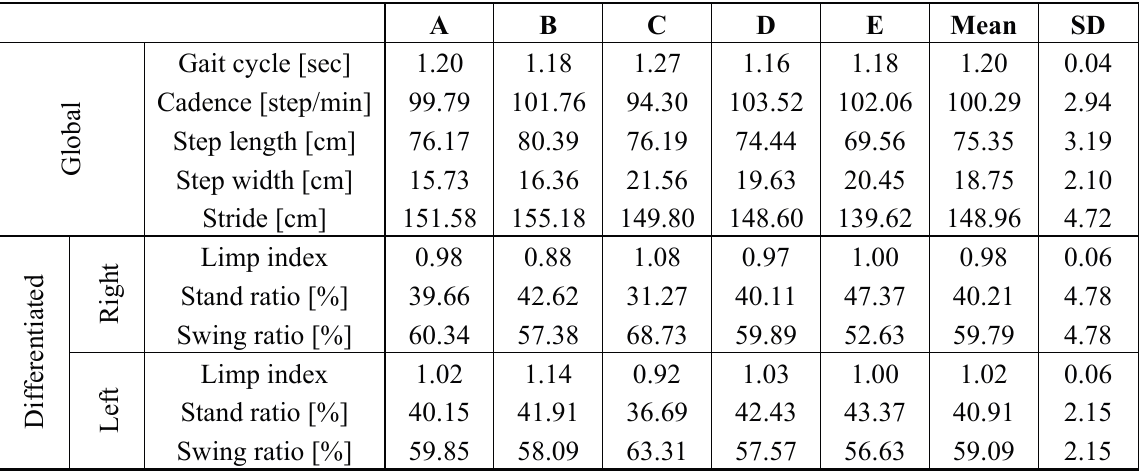
Table 3. Spatio-temporal gait parameters for each subject (A, B, C, D, E) for both right and left lower limb. Gait cycle, cadence, step length, step width, stride length, limp index, stand ratio and swing ratio are shown with mean and standard